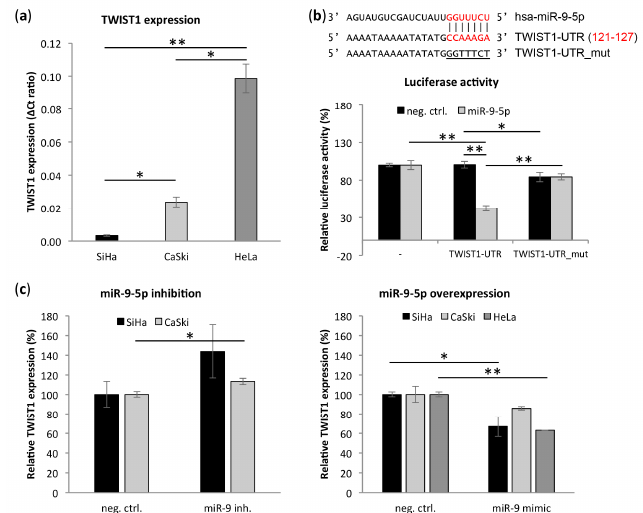
Figure 4. miR-9-5p directly targets transcription factor twist family bHLH transcription factor 1 (TWIST1). ( a ) Endogenous expression of TWIST1 mRNA in cervical cancer cell lines SiHa,